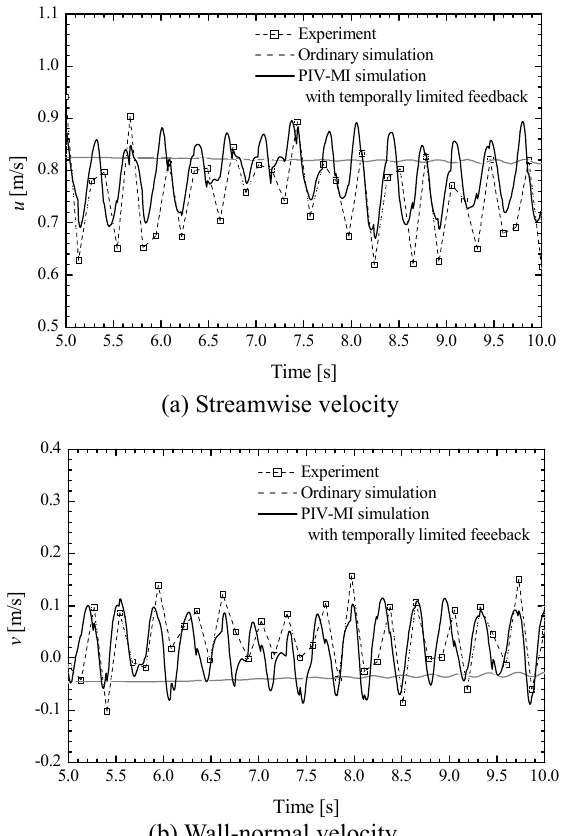
Fig. 7 Experimental validation of PIV-MI simulation with time histories of velocity at the monitoring